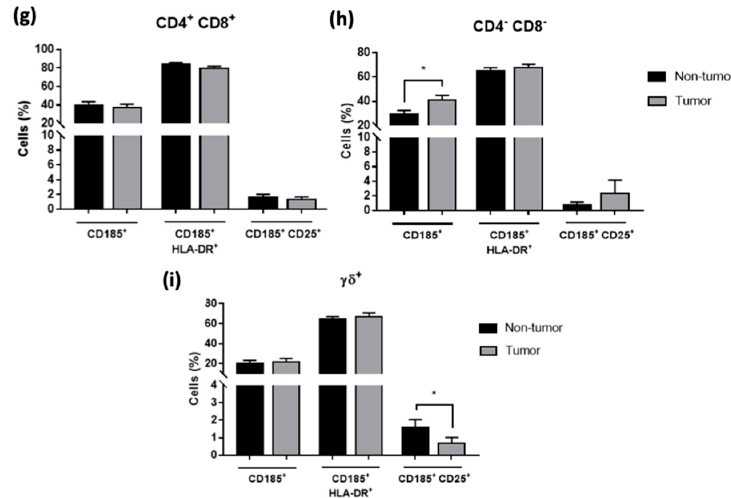
Figure 3. Flow cytometry analysis of T cells populations present in non-tumor and tumor samples of CRC liver metastasis. Percentage of Tregs in CD4 + ( a ), CD8 + ( b ) and CD4 + CD8 + ( c ) T lymphocytes. ( d ) Percentage of CD4 + CD185 + Tregs (follicular phenotype), and activated by the expression of the HLA-DR marker. ( e – i ) Analysis of the other follicular T cells (CD4 + , CD8 + , CD4 + CD8 + , CD4 — CD8 — and γδ + T lymphocytes), as well as their activation status by the expression of CD25 or HLA-DR. All results are shown as mean ± SEM. * p < 0.05, ** p < 0.01, *** p < 0.001 and **** p < 0.0001